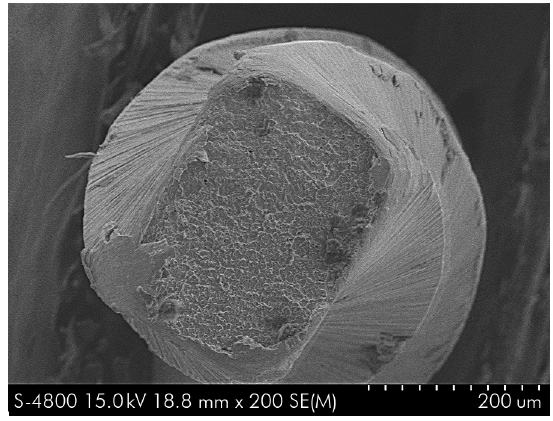
Figure 4. Scanning electron micrographs of the cross surface of the fractured ProTaper Next files from a 90° canal.